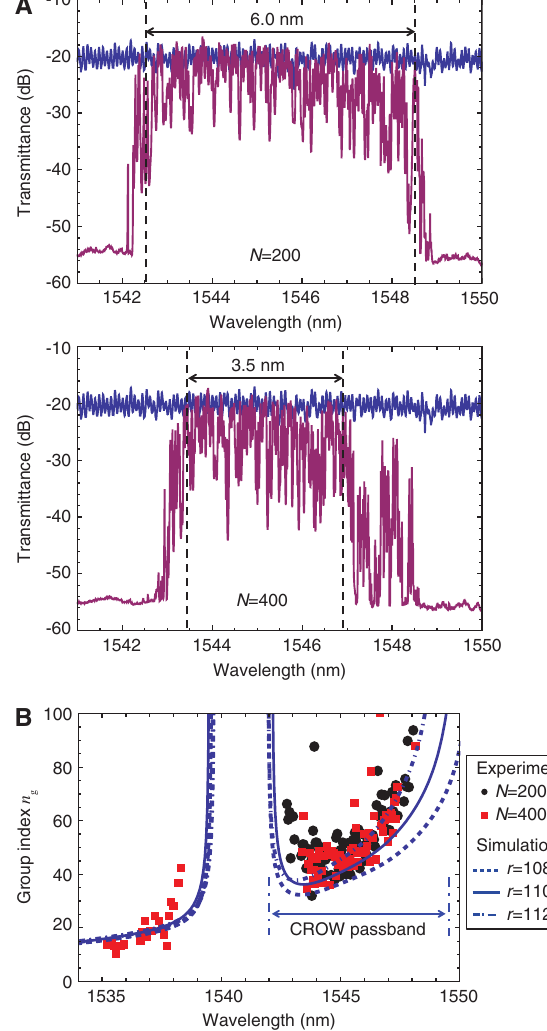
Figure 6: (A) Transmission spectra of CROWs (red curves) and a W1.05 line-defect waveguide (blue curves). (B) Measured group index spectra for CROWs with various cavity numbers along with the numerical simulation results based on the plane-wave expansion method. Figures from Ref.